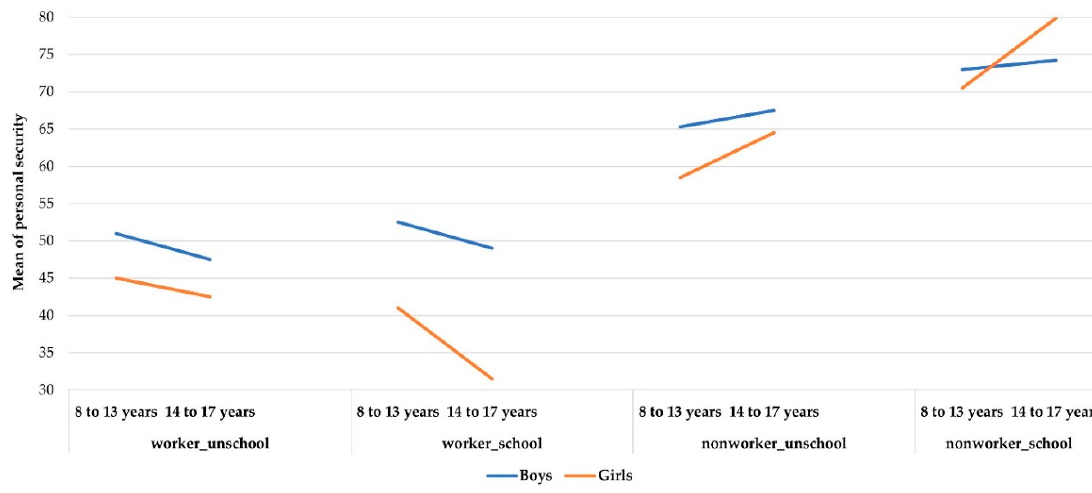
Figure 4. Gender differences for Personal Security.